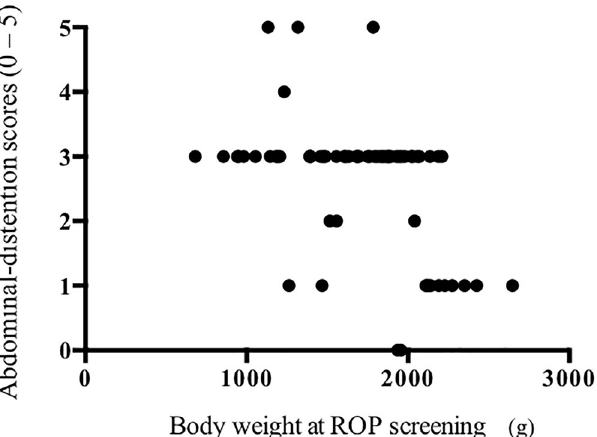
Fig 2. Correlation between body weights at retinopathy of prematurity (ROP) examinations and the scores of abdominal distention.